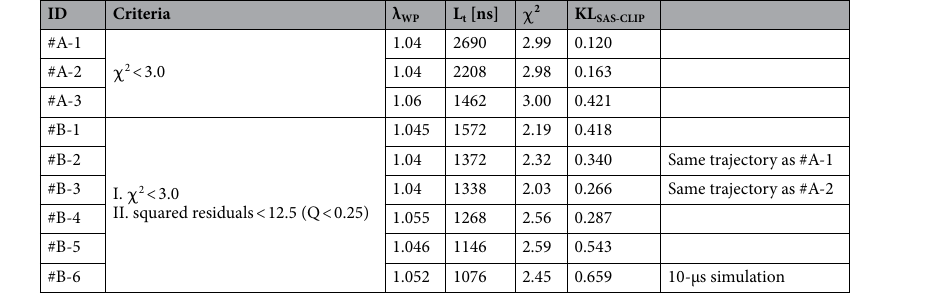
Table 1. λ WP , L t , χ 2 , and KL SAS-CLIP of time series obtained by the